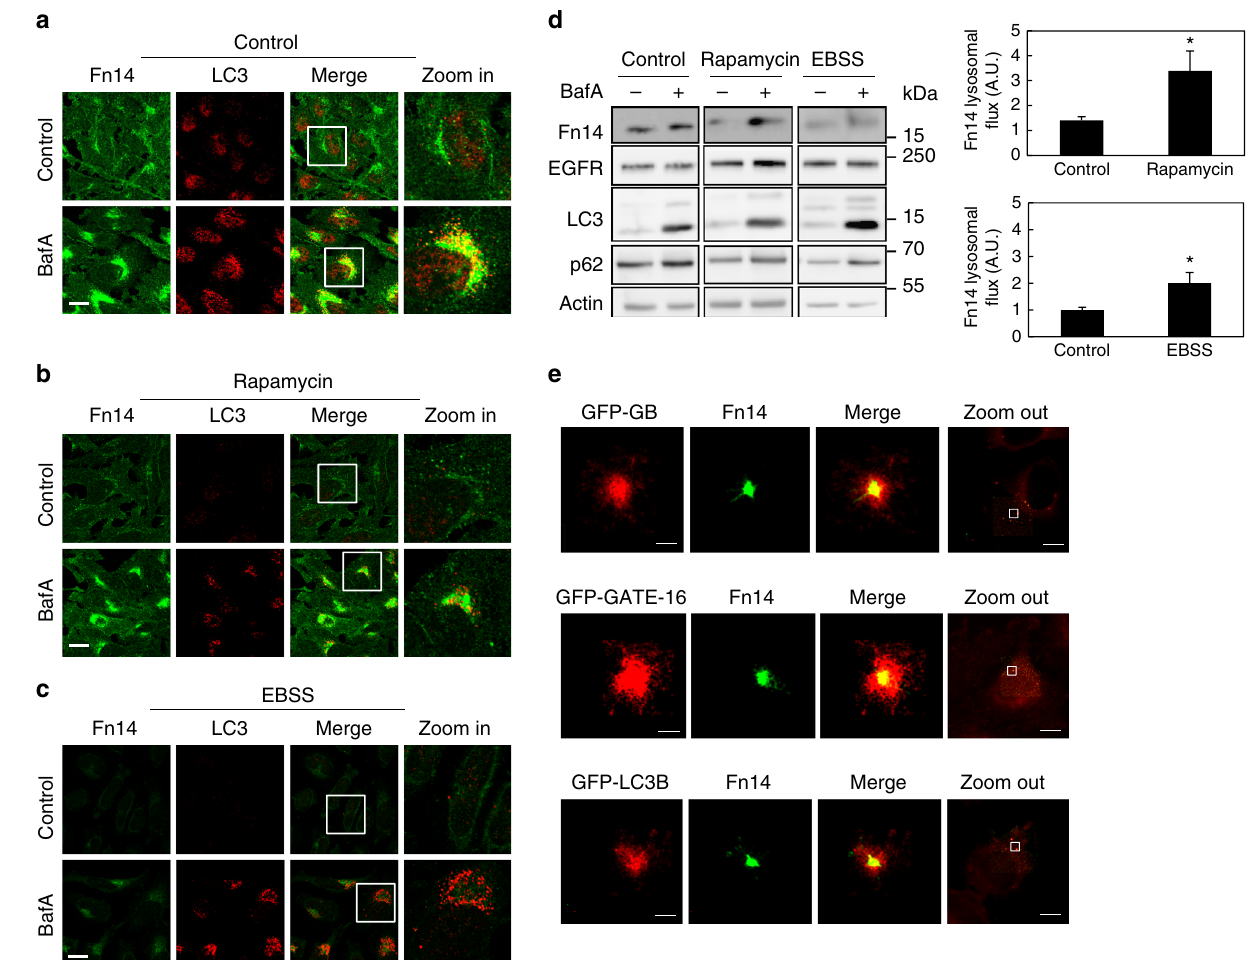
Fig. 3 Induction of autophagy augments the degradation of Fn14. a – c HeLa cells were incubated for 12 h with BafA as indicated without further treatment ( a ) or with rapamycin ( b ) or starved in EBSS ( c ), immunostained for Fn14 and LC3, and analyzed by confocal microscopy (scale bar, 20 µ m). Large magni fi cation of stained cells is presented in the right column. d Proteins extracted from cells treated as in a – c were immunoblotted (left panel) and lysosomal fl ux was calculated (right panel) (* P < 0.05, n = 2 biological repeats performed in triplicates, comparisons by T test; mean ± s.e.m). e HeLa cells stably expressing GFP-GABARAP (GFP-GB), GFP-GATE-16, and GFP-LC3B were immunostained for GFP and Fn14 and analyzed by 3D STORM (scale bar, 300 nm). Landscape images are presented in the right column (scale bar 10 μ